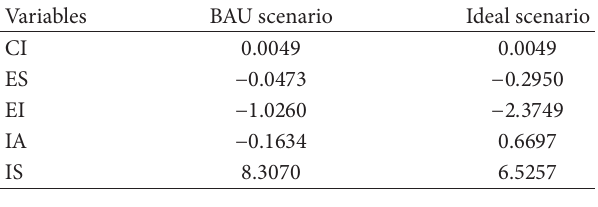
Table 2: Hypothesis of variables (unit: %).